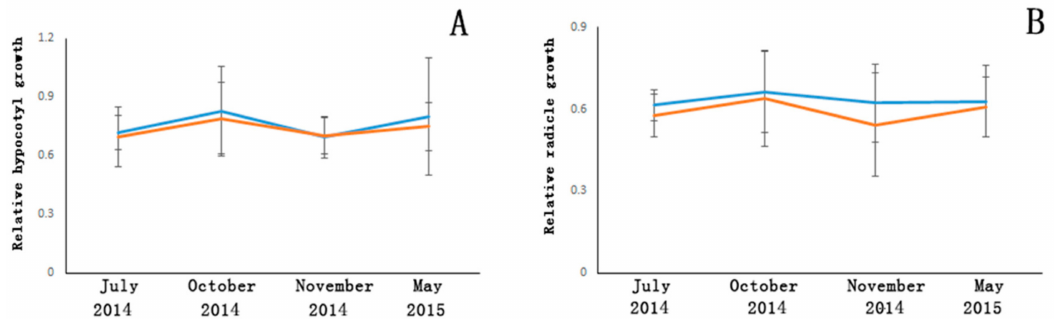
Figure 2. Changes in the allelopathic activity of leaf tissue from transgenic (blue) and non-transgenic (orange) Populus for relative hypocotyl ( A ) and radicle ( B ) growth compared to blank controls in different sampling time points as determined by the soil-mix method. No significant difference was detected between the transgenic group and non-transgenic group on respective samplings points ( α = 0.05).